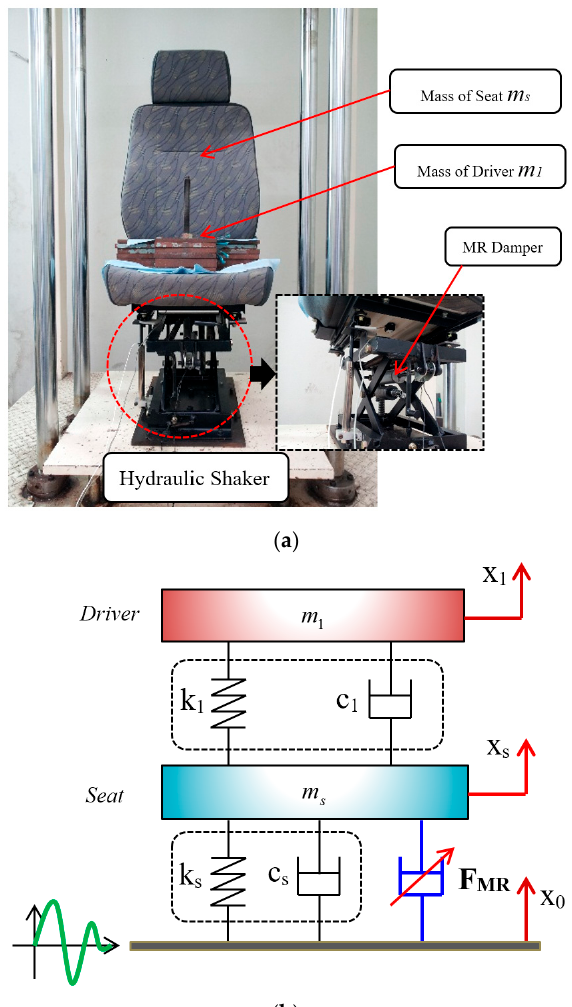
Figure 2. Seat suspension with MR damper for a commercial bus: ( a ) practical model (photograph); ( b ) mechanical model.